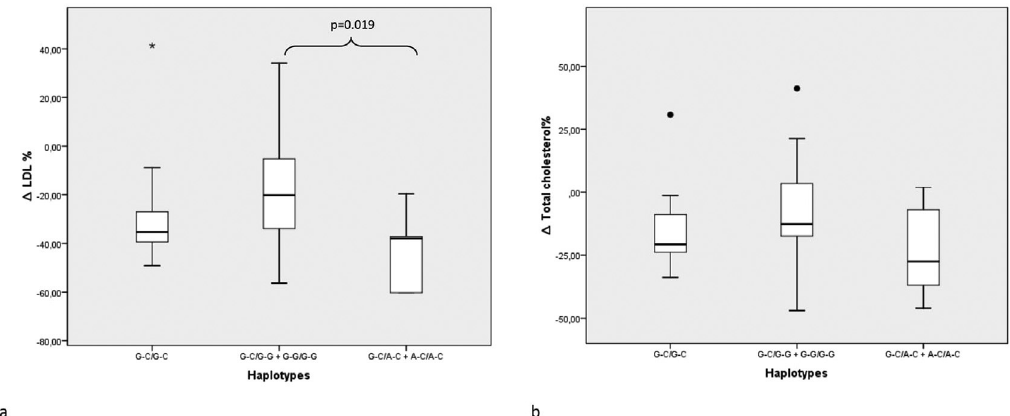
Figure1 -Comparisonofpercentvariationintotalcholesterolandlow-densitylipoproteinlevelsfollowingbariatricsurgeryamong ADIPOQ -11391G> A(rs17300539)and-11377C>G(rs266729)haplotypecombinations.(A)Comparisonofmedian%-variationinLDLlevelsamong ADIPOQ haplotype combinations. Kruskal-Wallis test among the three haplotype combinations, p = 0.029; Mann-Whitney test used to show difference between G-G carriers and A-C carriers medians, p = 0.019. *Outlier individual value of (cid:4) LDL%. (cid:4) LDL%, percentual variation in low-density lipoprotein levels. (B) Compari- son of median % variation in total cholesterol levels among ADIPOQ haplotype combinations. Kruskal-Wallis test among the three haplotype combina- tions, p = 0.178. (cid:129) Outlier individual values of (cid:4) total cholesterol %. (cid:4) , variation. Data are shown as median and interquartile range adjusted for the time interval between data